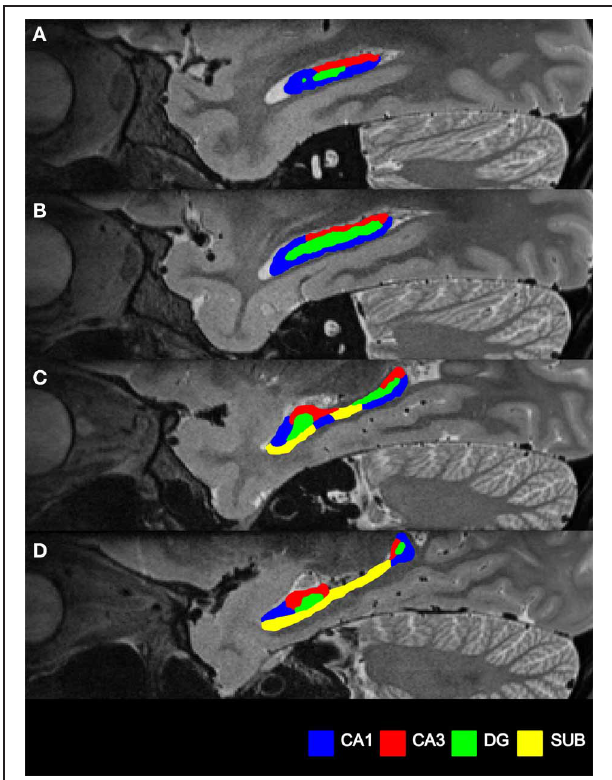
FIGURE 3 | Subfield segmentation in the sagittal plane. (A) Sagittal section through an averaged T2-weighted image of the hippocampus of a participant. Blue indicates CA1, red indicates CA3, the DG in green becoming visible. (B) Proceeding medially through the hippocampus. (C) The body starts to thin and subiculum (yellow) replaces part of CA1. (D) Only head and tail remain at the medial end of the hippocampus, with now most of the subiculum in